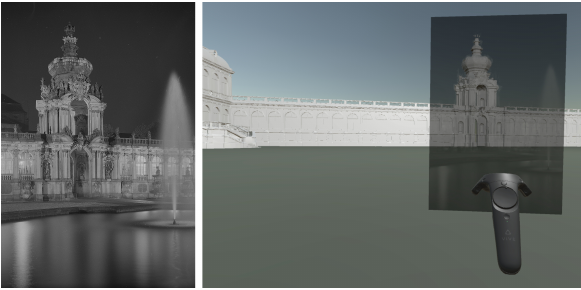
Figure 6. HMD-based VR game to find location and orientation of photographer. Right: Semi-transparent VR overlay